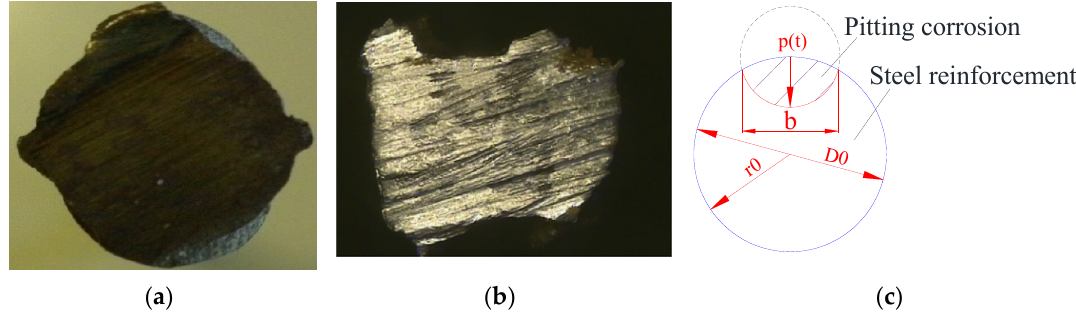
Figure 2. Simplification and comparison of the corrosion morphology [22–23]. ( a ) Non-corroded image. ( b ) Natural corroded image. ( c ) Melchers & Val’s model.